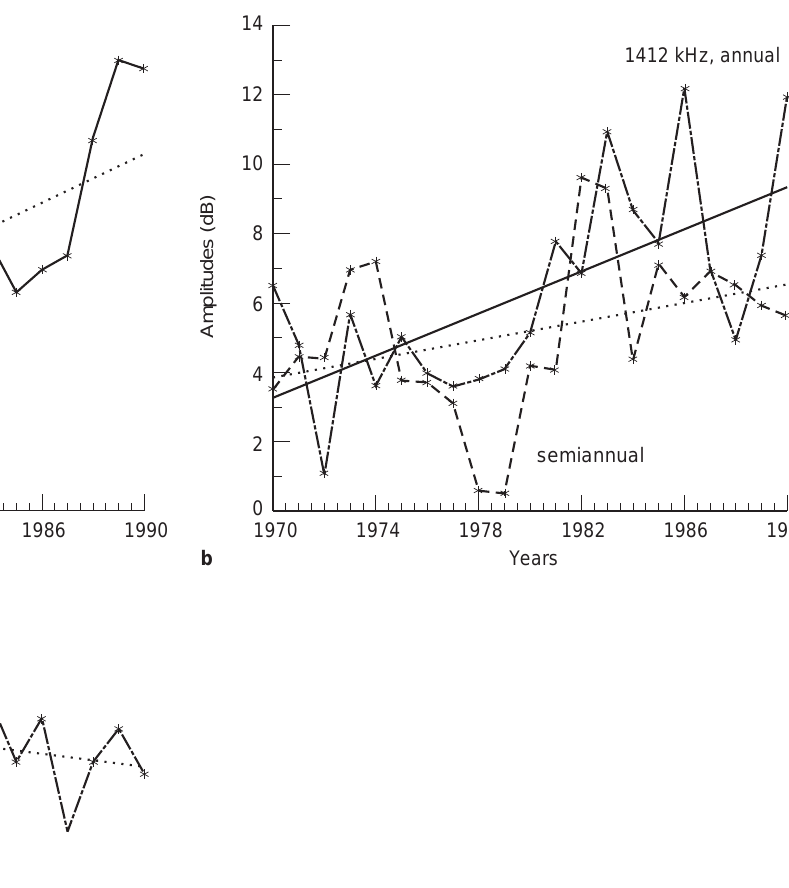
Fig. 3. a Trend in the yearly constant (slope = +0.893 dB/y) at 1412 kHz, 1970–1990. b Trends in the amplitudes of the AW ( Solid curve ; k = +0.304 dB/y) and SAW ( dashed curve ; k = +0.136 dB/ y) in absorption at 1412 kHz, 1970–1990; k – slopes of curve. c Trends in the phases of the AW ( top curve ; k = ) 2.108 day/y) and SAW ( bottom curve ; k = ) 1.037 day/y) in absorption at 1412 kHz, 1970– 1990; k – slopes